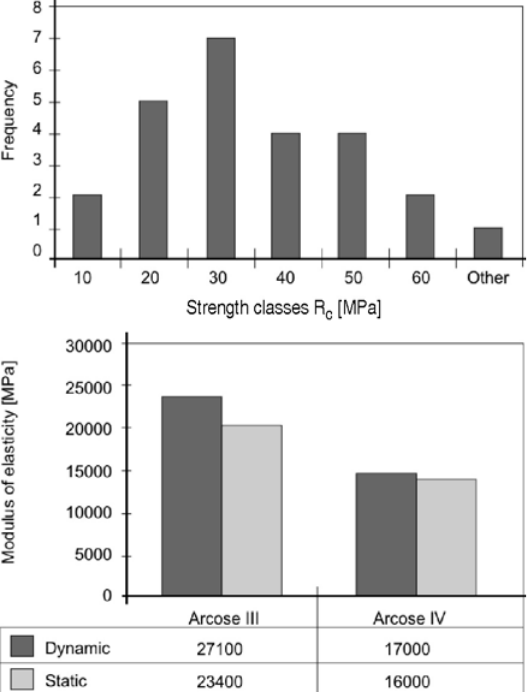
Fig 7. Bar chart of compressive strength frequency (a); mutual comparison of dynamic and static moduli of elas- ticity